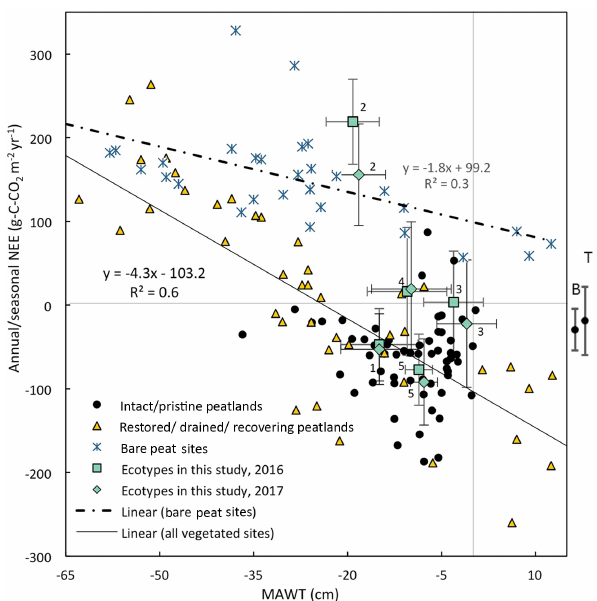
Figure 12. This figure shows the mean annual water table plotted against the measured 2017 annual CH 4 emissions for each ecotype in this study (error bars are standard deviations) and from global studies of temperate and boreal peatlands (sources: Flessa et al., 1998; Fieldler et al., 1998; Renou-Wilson et al., 2018b; Tuittila et al., 1999; Nykänen et al., 1998; Danevˇciˇc et al., 2010; Von Arnold et al., 2005; Laine et al., 1996; Yamulki et al., 2013; Jungkunst and Fiedler, 2007; Jungkunst and Fiedler, 2007; Cooper et al., 2014; Waddington and Day, 2007; Chimner et al., 2017; Waddington and Roulet, 2000; Ballantyne et al., 2014; for more details see Table S9. Also, shown to the right of the figure is the mean and 95% CI of CH 4 emissions from nutrient-poor, wet (MAWT > − 30cm) boreal (B) and temperate (T) peatlands (from the review paper Wilson et al., 2016a). Numbering of ecotypes is the same as in Fig.